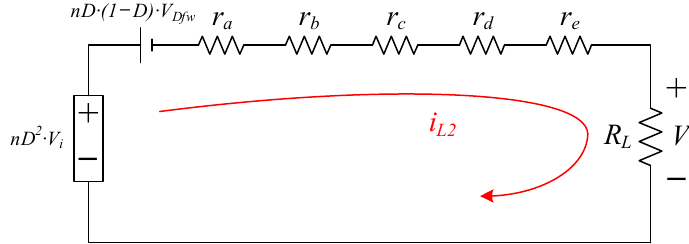
Figure 19. Simple equivalent circuit module using Equation (98).